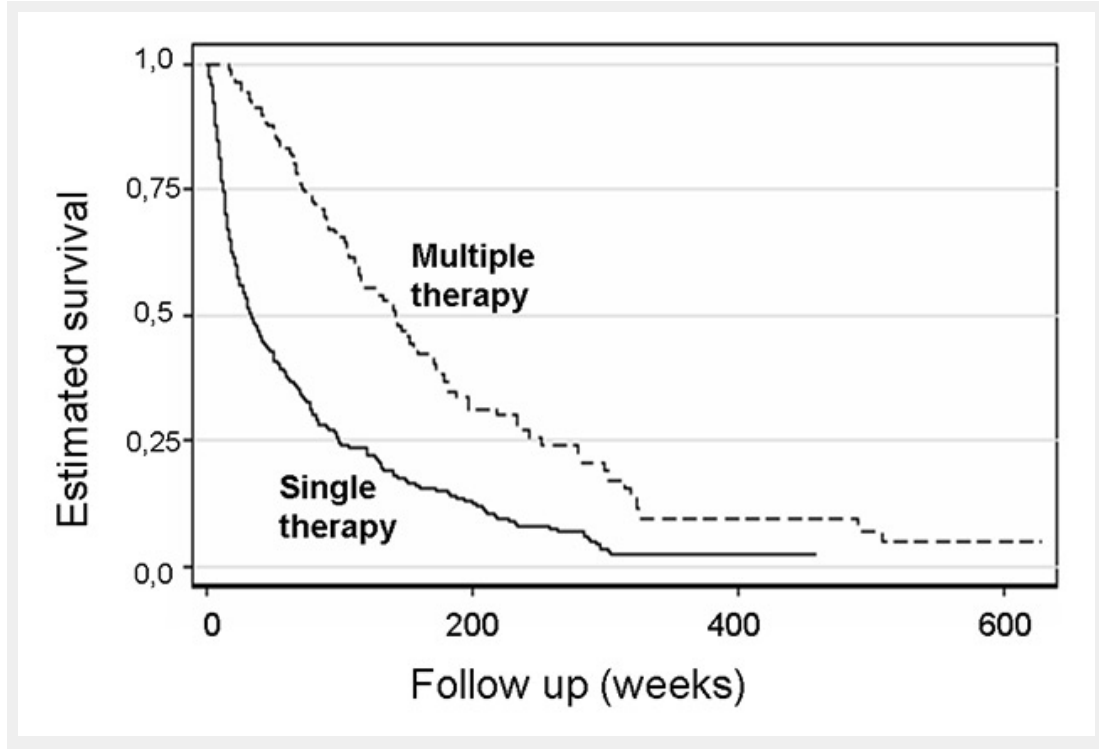
Figure 5 Kaplan-Meier curve for survival of patients with hepatocellular cancer receiving single or multiple therapies (n = 347 and 137 for multiple and single therapy, respectively, p